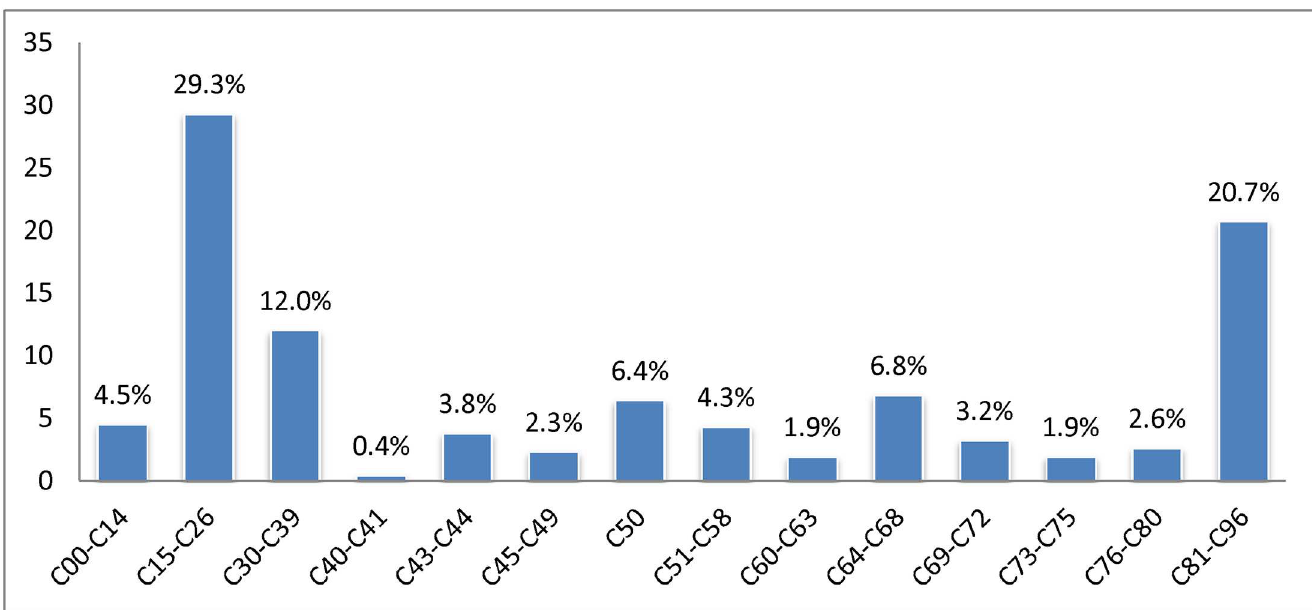
Fig 1. The distribution of the tumor entity of deceased cancer patients (N = 532). C00-C14:Malignant neoplasmsof lip, oral cavity and pharynx, C15-C26: Malignantneoplasms of digestiveorgans, C30-C39:Malignant neoplasms of respiratory and intrathoracic organs, C40-C41: Malignant neoplasms of bone and articular cartilage, C43-C44,Melanomaand other malignant neoplasmsof skin, C45-C49:Malignant neoplasms of mesothelial and soft tissue, C50: Malignantneoplasmsof breast, C51-C58:Malignant neoplasmsof female genital organs, C60-C63: Malignantneoplasms of male genital organs, C64-C68:Malignant neoplasmsof urinary tract, C69-C72:Malignant neoplasms of eye, brain and other parts of central nervoussystem, C73-C75: Malignantneoplasms of thyroid and other endocrine glands, C76-C80:Malignantneoplasms of ill-defined,other secondary and unspecified sites, C81-C96:Malignantneoplasms of lymphoid,hematopoietic and related tissue.